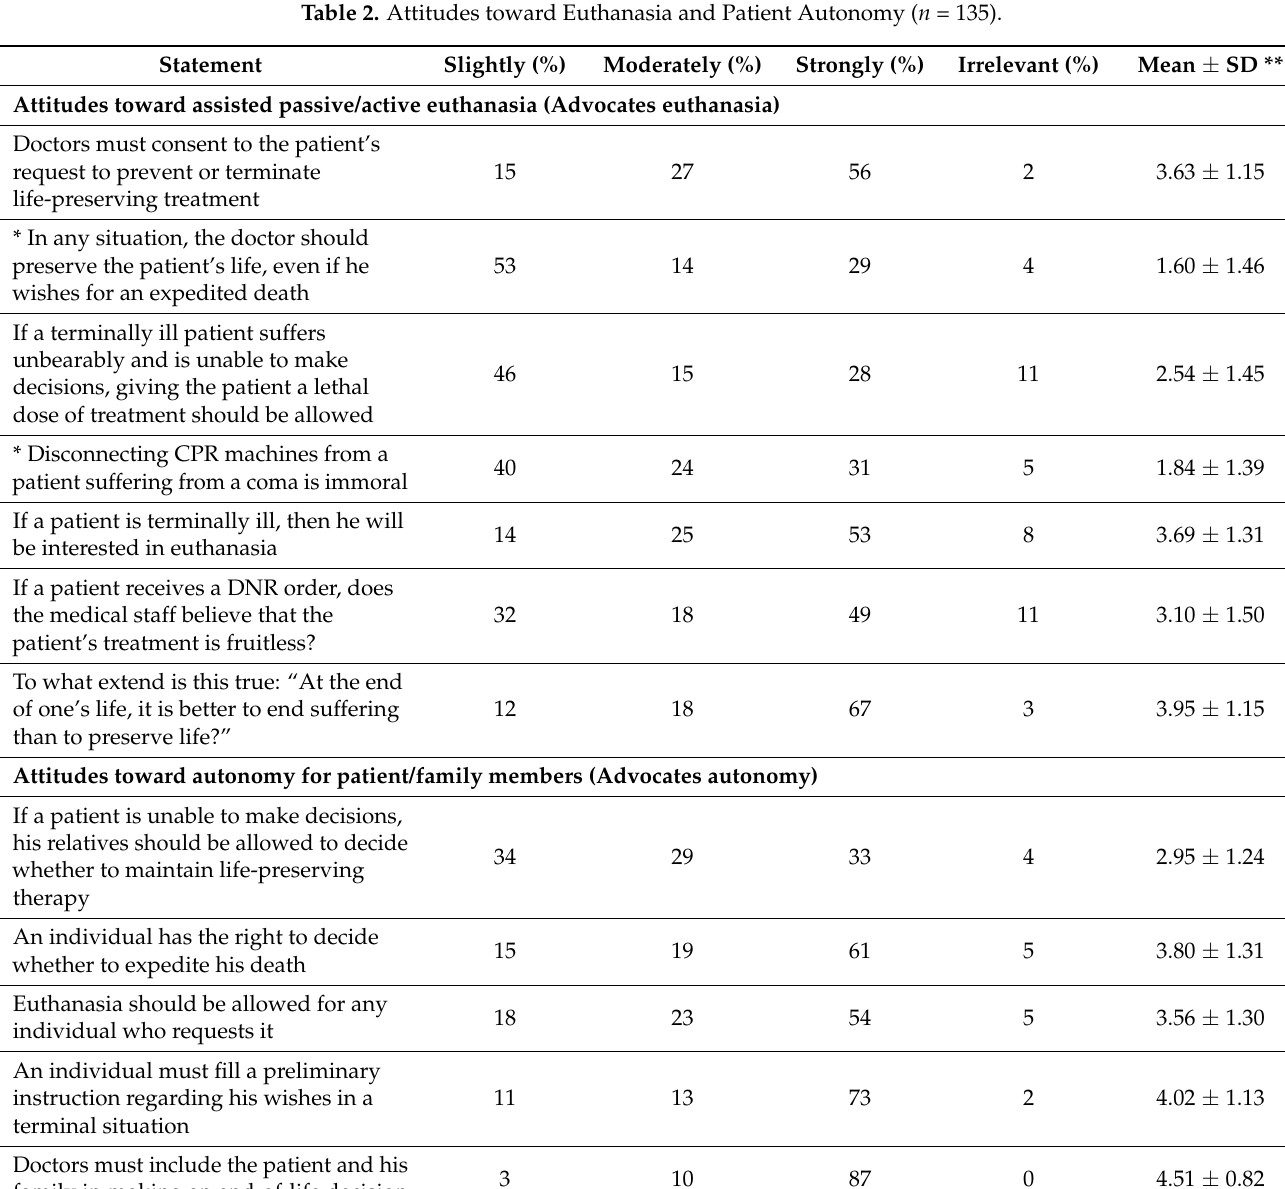
Table 2. Attitudes toward Euthanasia and Patient Autonomy ( n =